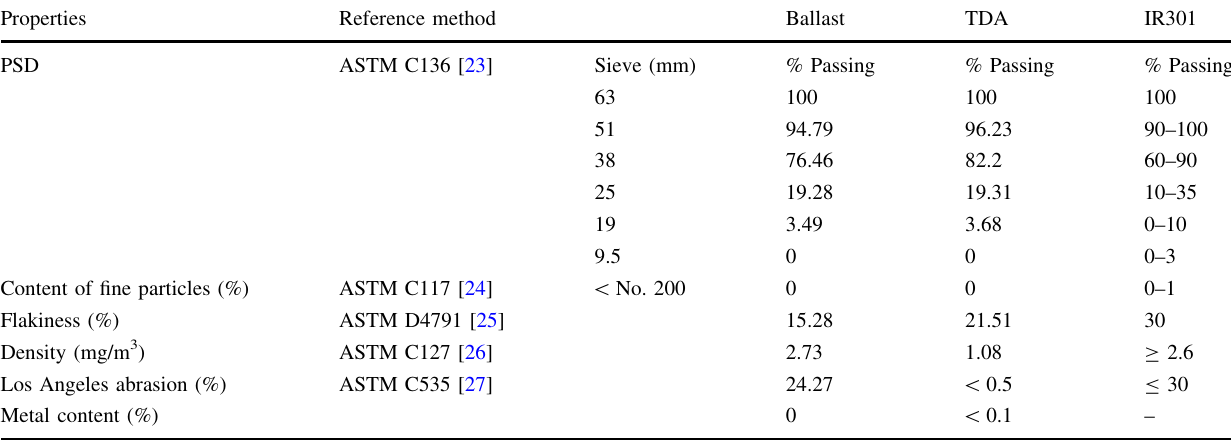
Table 2 Technical specifications of the used